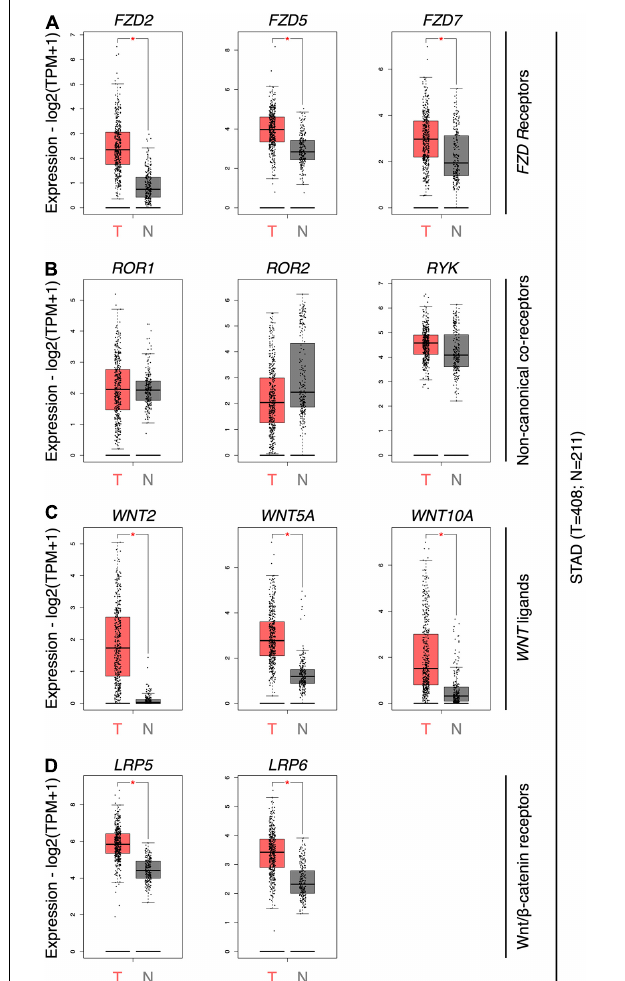
FIGURE 1 | Gene expression profile for selected WNT components in GC. (A) The abundance of FZD2 , FZD5 , and FZD7 genes in GC tumor tissue (T; n = 408) and normal adjacent tissue and matched GTEx data ( N ; n = 211) samples. (B) Abundance of ROR1 , ROR2 , and RYK genes; (C) WNT2 , WNT5A , and WNT10A genes; and (D) LRP5 and LRP6 genes. Differential expression is calculated by one-way ANOVA. Expression data is shown as log2(TPM + 1); TPM, transcripts per million. *, differentially expressed genes.